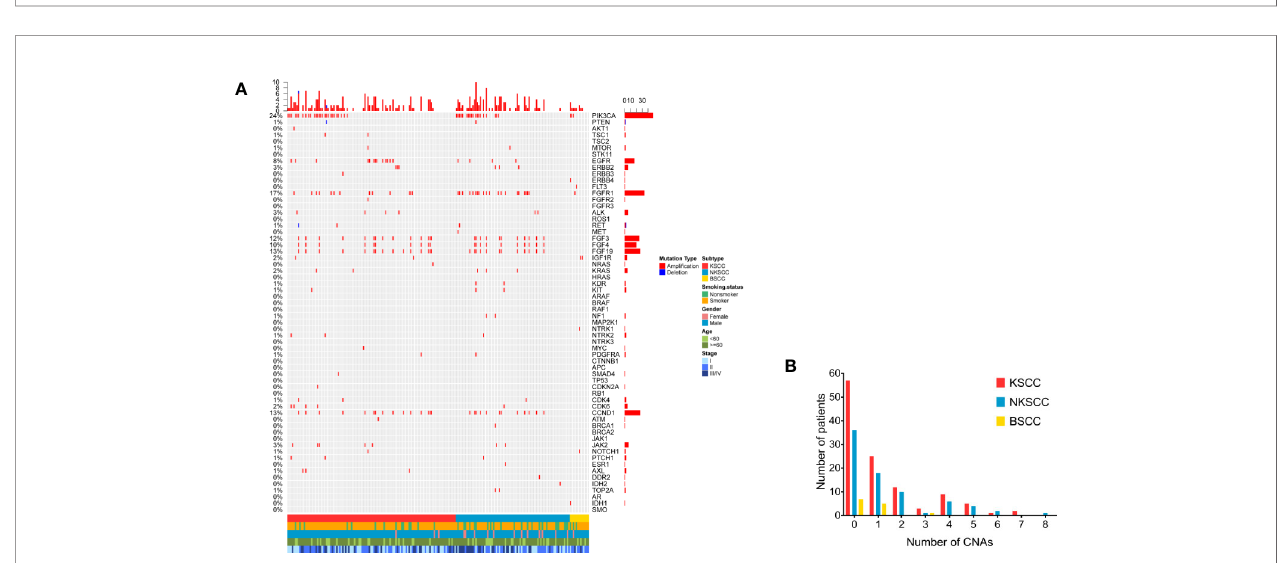
FIGURE 3 | (A) The spectra of copy number alterations of the LUSC patients grouped according to histological subtypes. Smoking status, gender, age, and disease stage were also annotated at the bottom of the oncoprint. Each column represents a patient and each row represents a gene. Column on the left represents the alteration rate of each gene. Column on the right represents genes. Top plot represents the overall number of alterations a patient carried. Different colors denote different types of alteration (B) . Copy number alterations frequency of LUSC patients according to their histological subtypes. X-axis denotes number of copy number alterations, Y-axis denotes number of patients. LUSC, lung squamous cell carcinoma; KSCC, keratinizing squamous cell carcinoma; NKSCC, non-keratinizing squamous cell carcinoma; BSCC, basaloid squamous cell carcinoma.